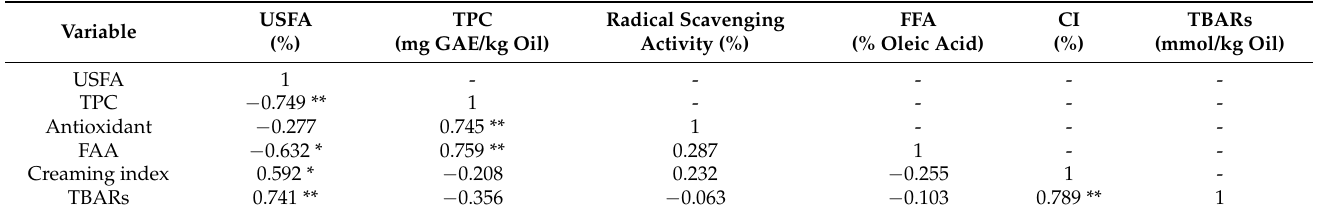
Table 2. Pearson’s correlation coefficients between the unsaturated fatty acids content (USFA), total phenolic content (TPC), radical scavenging activity, free fatty acids (FFA) of oils and the creaming